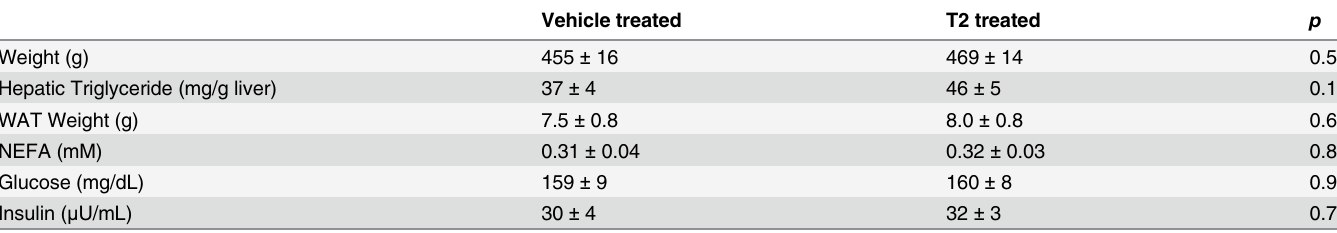
Table 3. Six-hour fasting parameters, four weeks T2